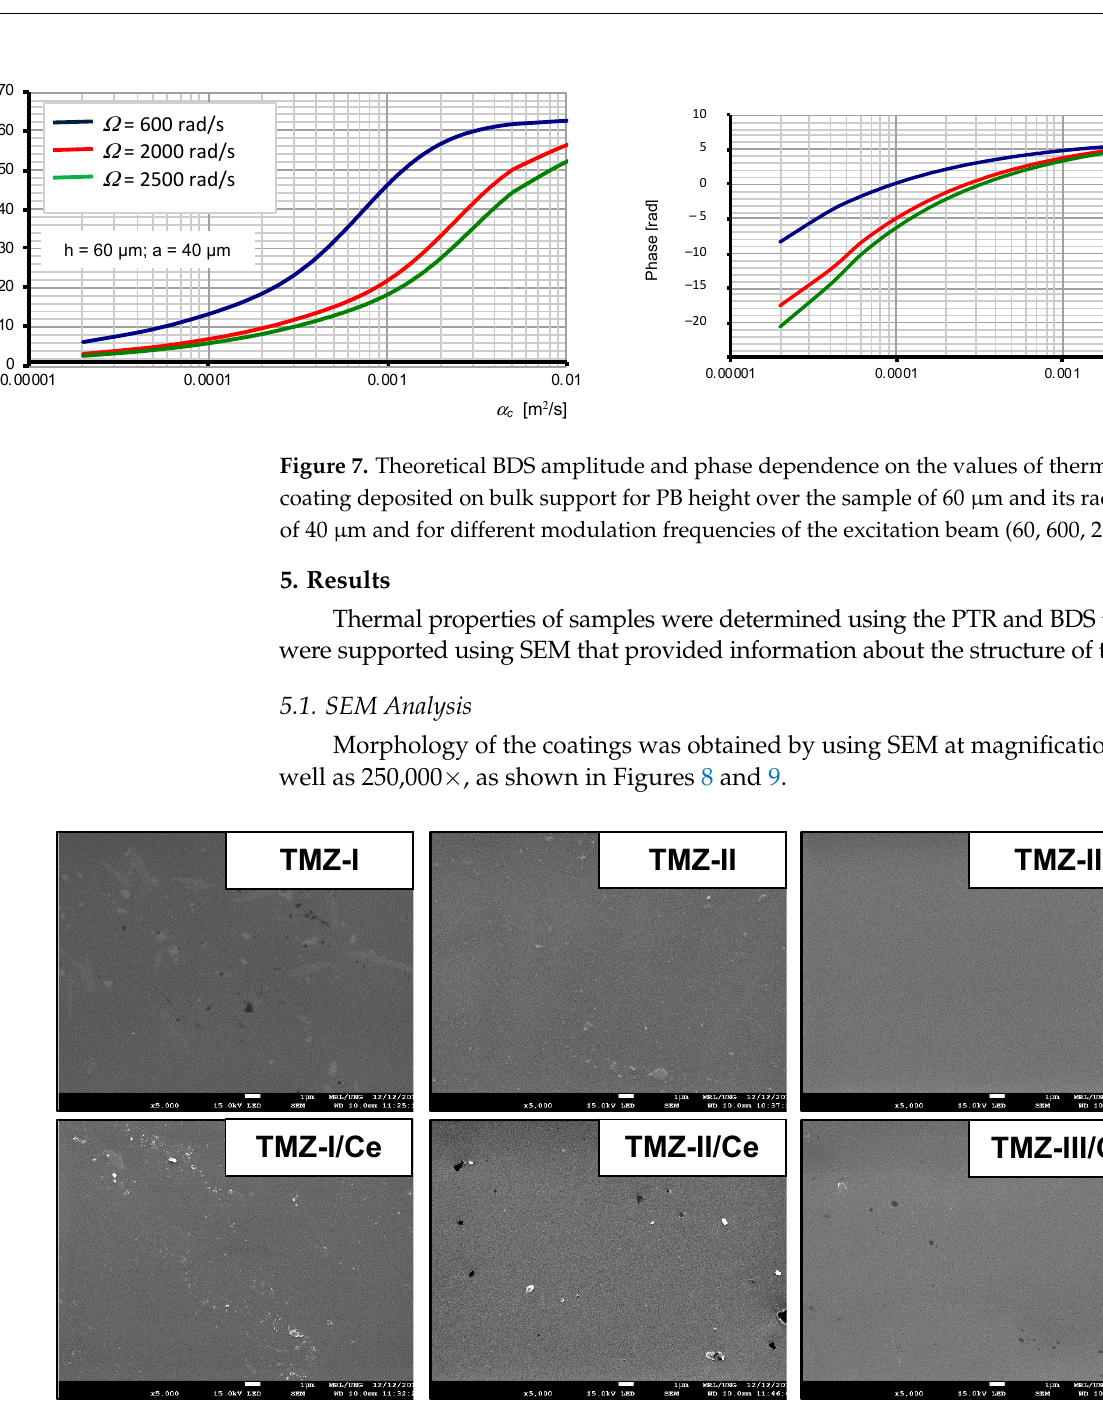
Figure 7. Theoretical BDS amplitude and phase dependence on the values of thermal diffusivity of coating deposited on bulk support for PB height over the sample of 60 μ m and its radius in the waist of 40 μ m and for different modulation frequencies of the excitation beam (60, 600, 2000 rad/s).